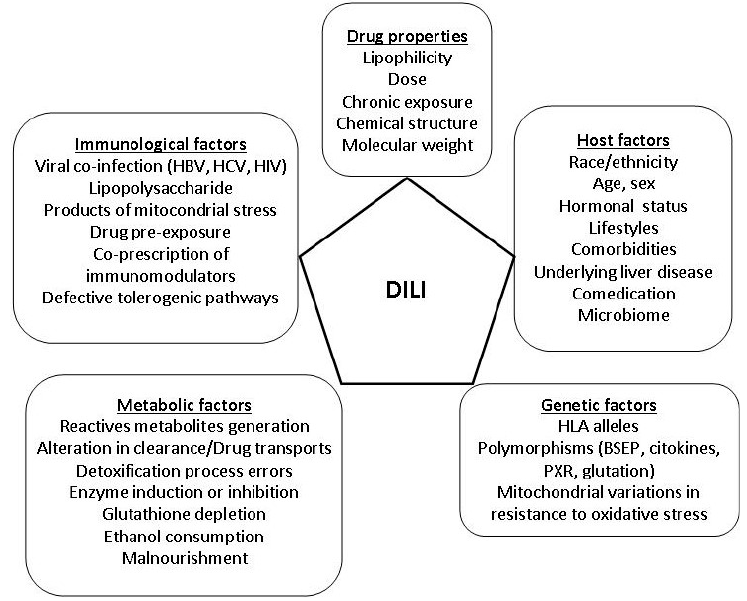
Figure 1. Risk factors in DILI.